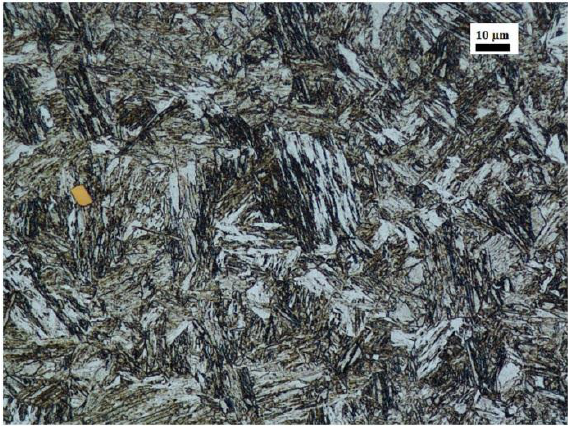
Figure 1. The microstructure of the investigated low-alloy boron steel with a high resistance to abrasive wear in the as-received state. Etched state, light microscope.